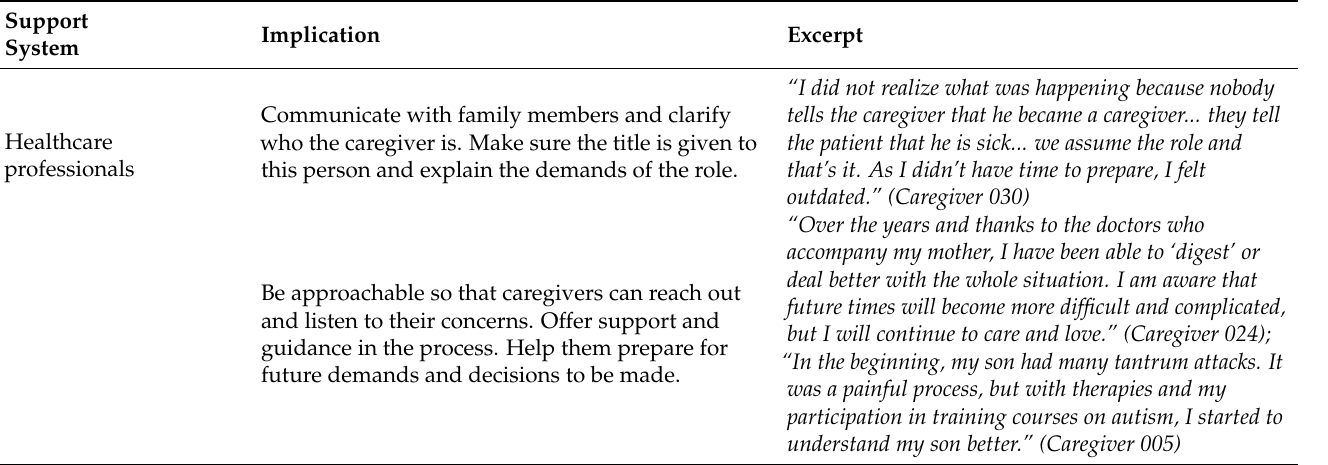
Table 7. Practical implications to the support